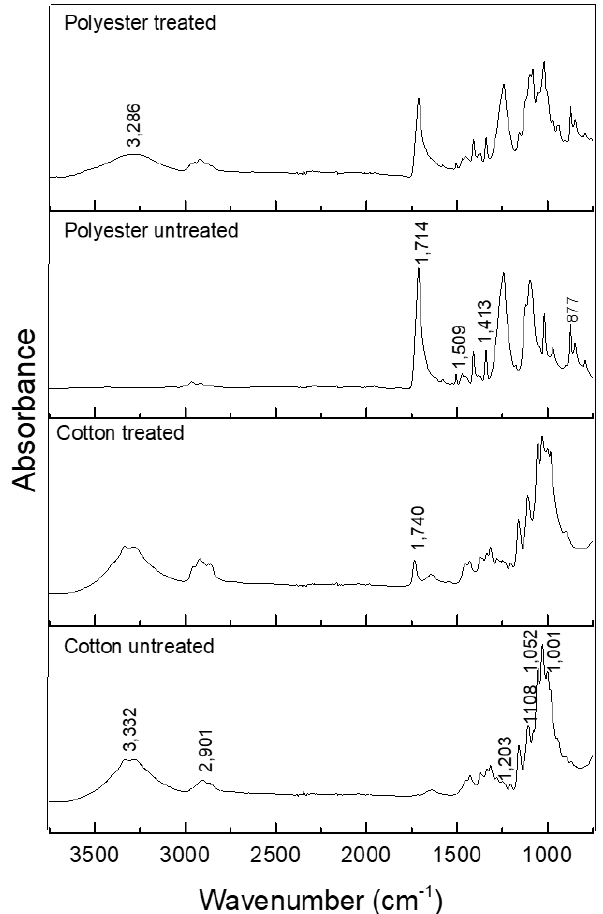
Figure 6. ATR-FTIR spectra of treated and untreated cotton and polyester textile.